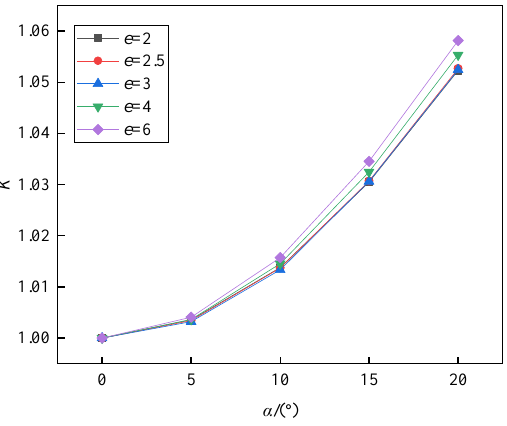
Figure 7. Correction coefficient K vs. α ( Re = 1.0 × 10 7 ).